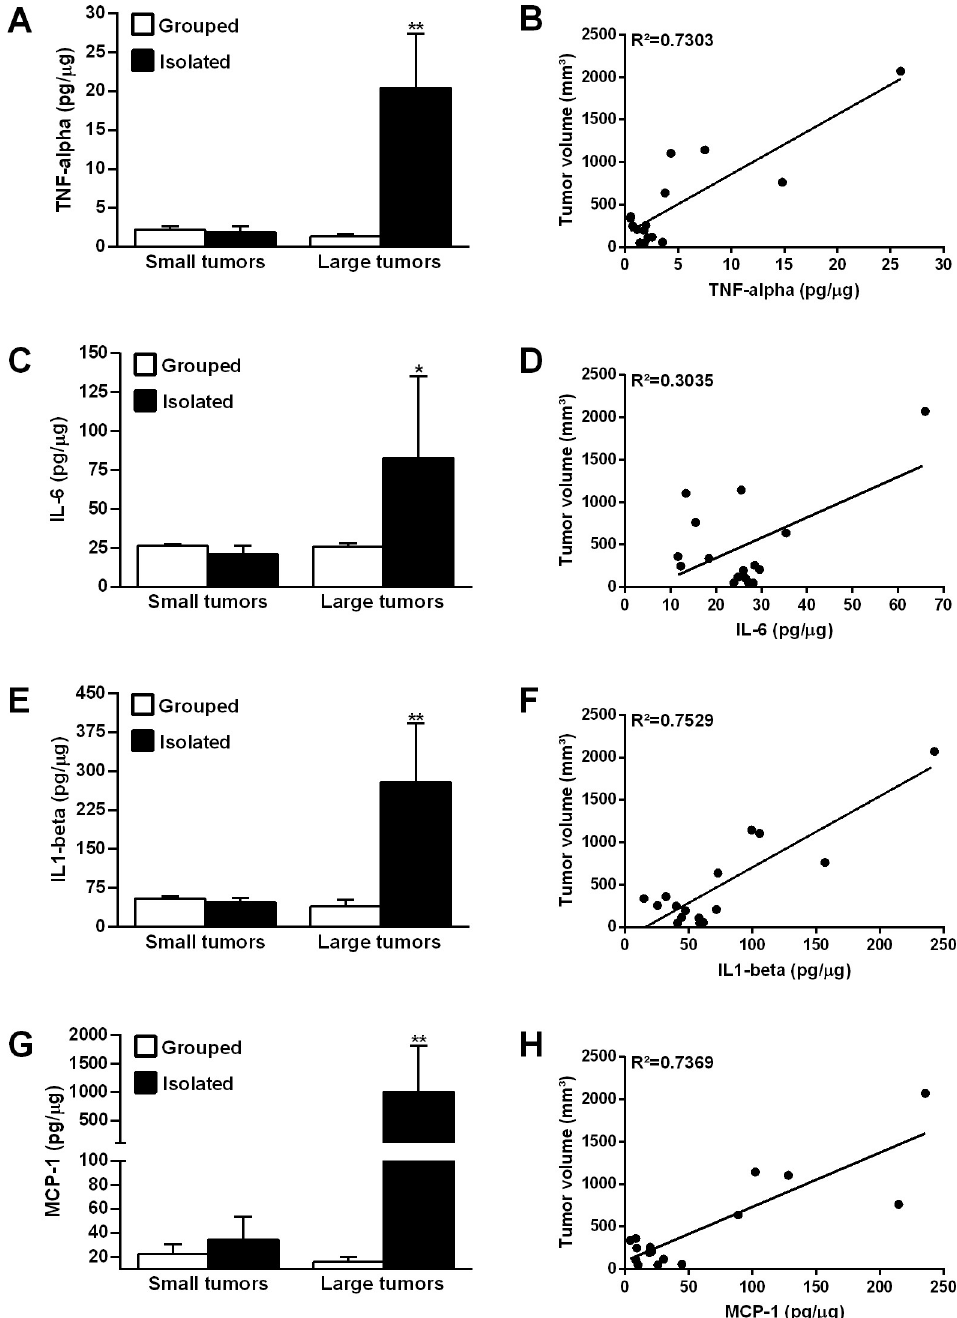
Fig 4. Levels of the tumor inflammatory mediators according the OSCC stage. TNF-alpha (A) , IL-6 (C) , IL1-beta (E) and MCP-1 levels (G) . ANOVA followed by Tukey multiple comparison demonstrated that the levels of inflammatory mediators were increased in the large tumors from isolated rats. Correlation between levels of the inflammatory mediators and OSCC volume. The Pearson correlation test showed a positive relationship between the tumor levels of TNF-alpha (B) , IL-6 (D) , IL1-beta (F) and MCP-1 (H) and tumor volume. � p < 0.05 indicates a statistically significant difference. � p < 0.05 and �� p < 0.001. Bar graphs represent the mean ± standard error of the mean (SEM).